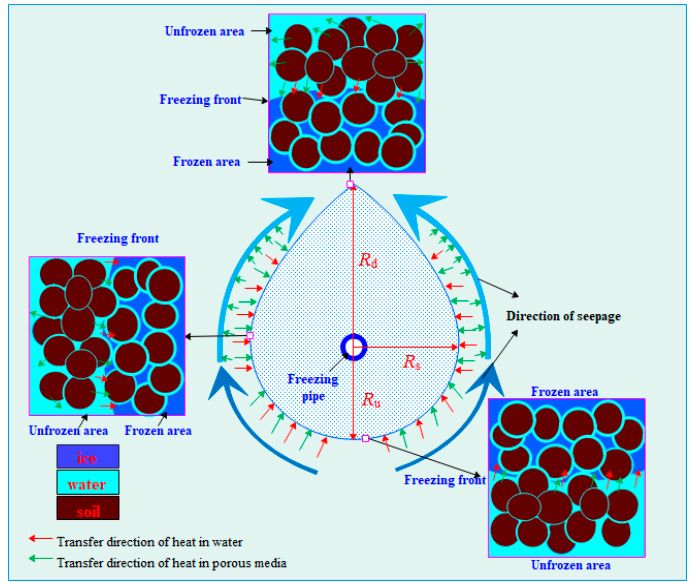
Figure 5. Heat transfer mechanism of ground freezing process under the action of groundwater.